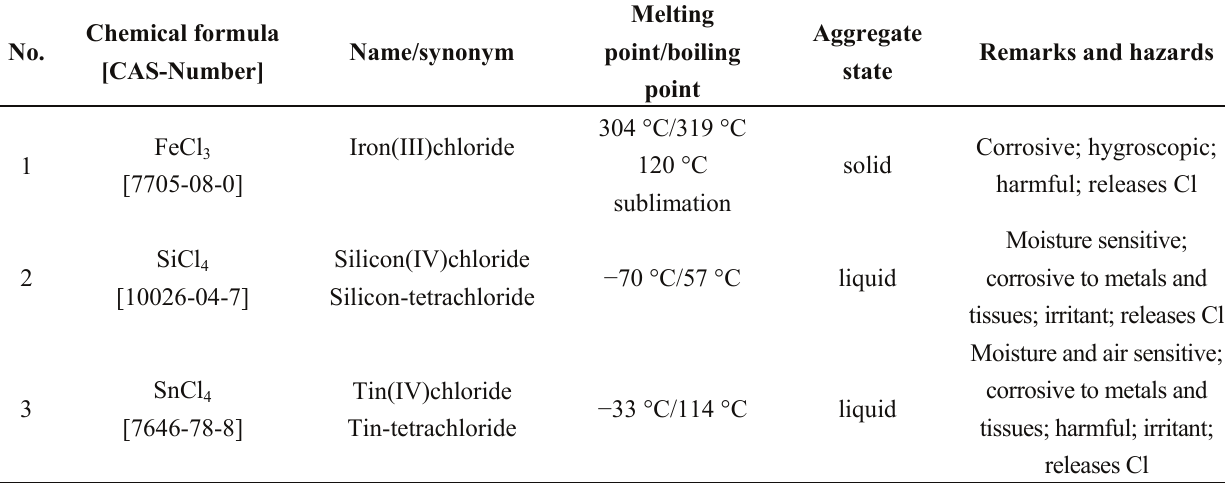
Table 1. Selection of different commercially available, solid, liquid, or gaseous, and volatile precursors typically used in microwave plasma nanoparticle